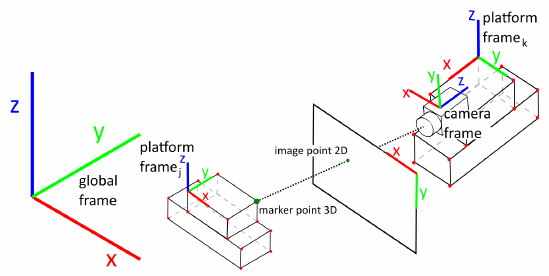
Figure 4. Relationship between a marker point on a cooperating platform and its position observed in the